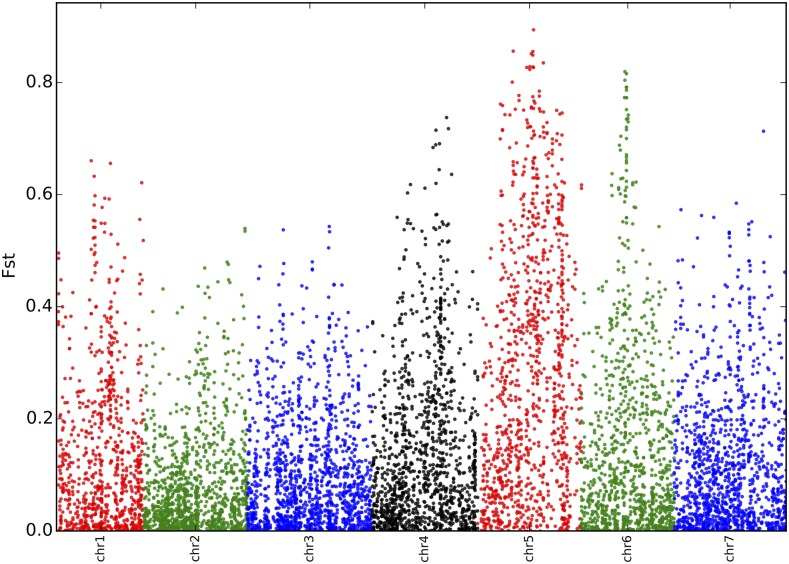
Manhattan plot of FST values across the genome contrasting spring vs. winter peas. SNPs are ordered according to Tayeh et al. (2015a).